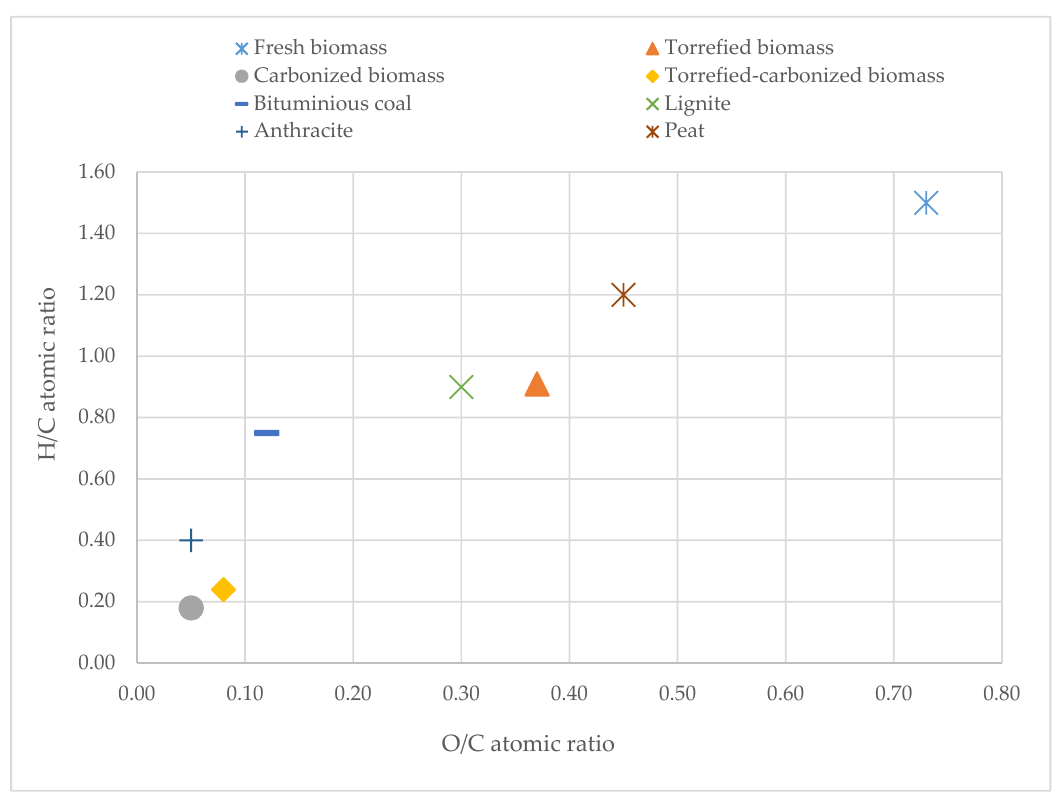
Figure 1. Van Krevelen diagram for fresh biomass, torrefied biomass, carbonized biomass, and torrefied ‐ carbonized biomass.